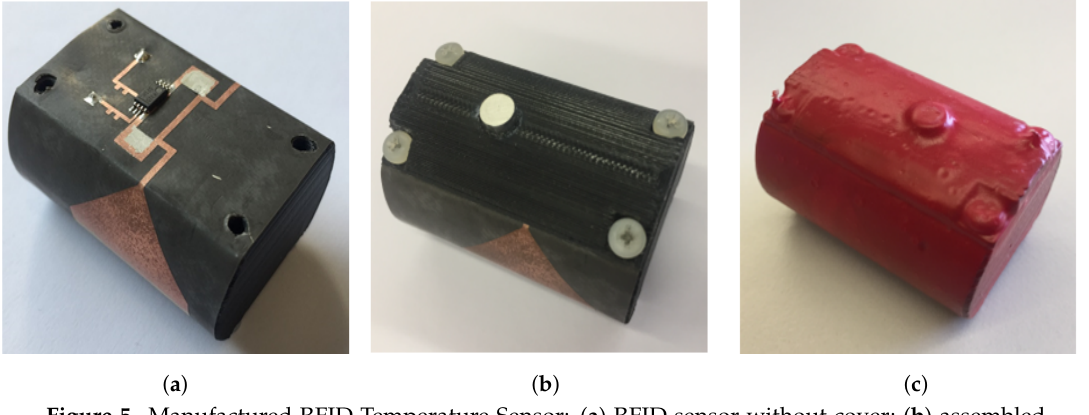
Figure 5. Manufactured RFID Temperature Sensor: ( a ) RFID sensor without cover; ( b ) assembled sensor; and ( c ) sensor after protection layer. Table 1. Technical features of the RFID temperature